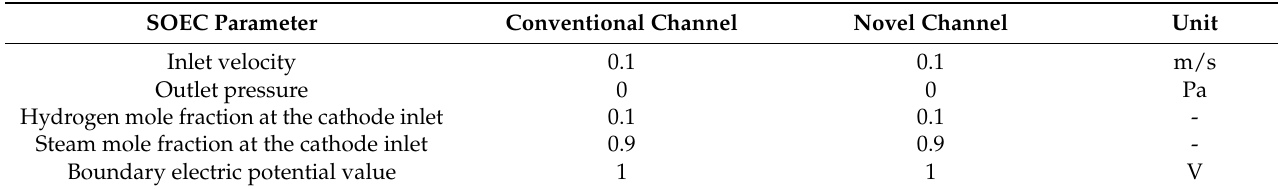
Table 2. Boundary conditions of the conventional channel and the novel